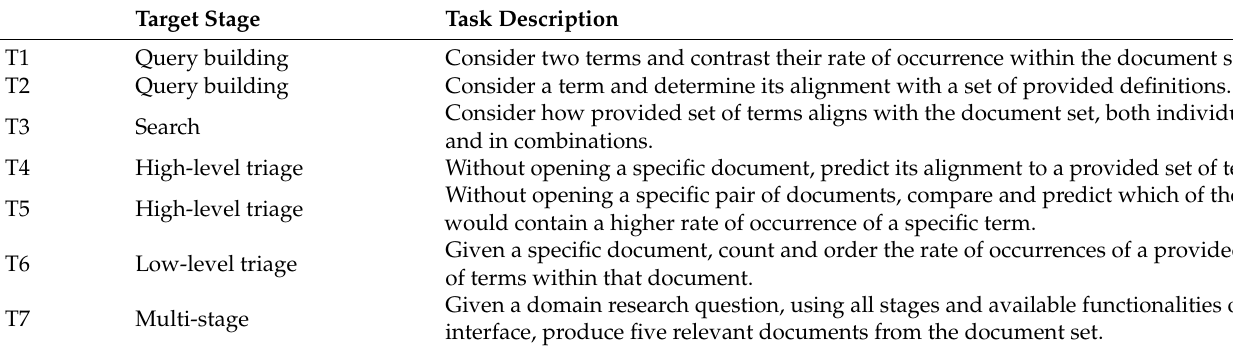
Table 4. General description of tasks (T1 . . . T7) performed during formative